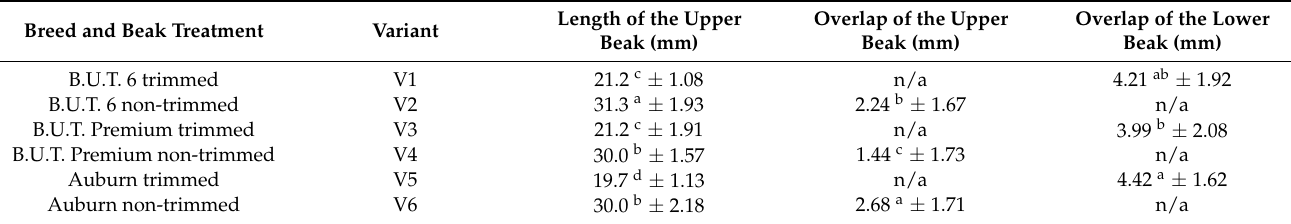
Table 6. Beak measurements and the standard deviation ( ± ) in millimeters (mm) at the end of Phase 6 (137th DOL) ( n = 523) in relation to the variant. The length of the upper beak in millimeters was measured from the anterior edge of the nares to the tip of the